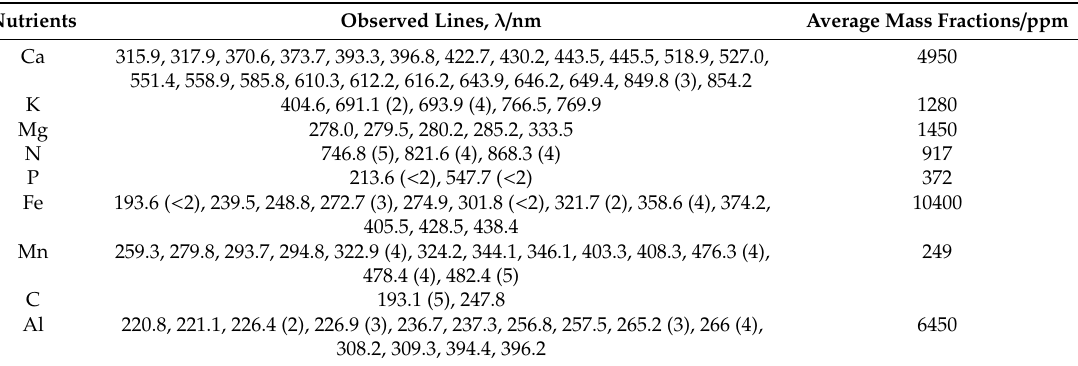
Table 1. Summary of the lines and the average mass fractions of the nutrients determined by reference analytics ICP-OES, signal-to-noise ratios of very weak lines in